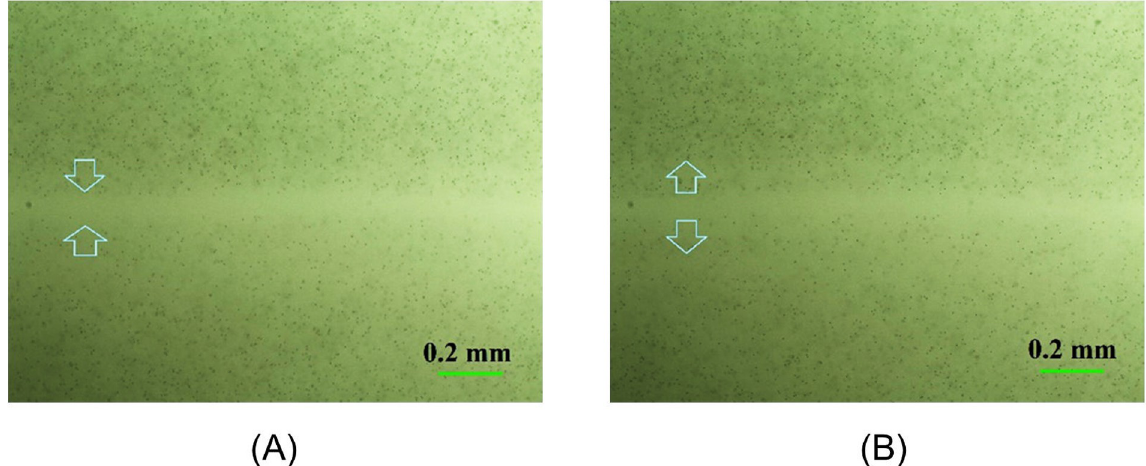
Fig 6. Microsphere-free band forms between magnets 1 and 2. (A) near the surface, (B) near the bottom of the Petri dish. The arrows show the directions of microsphere motion at the respective